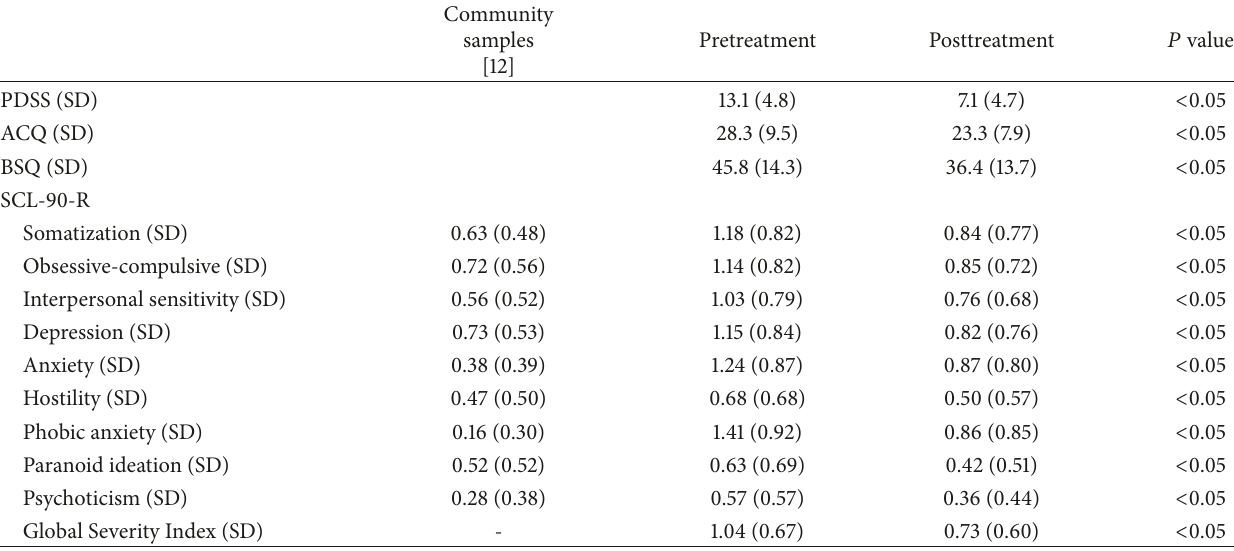
Table 2: Pretreatment and posttreatment rating scale scores (𝑁 = 200) . Community